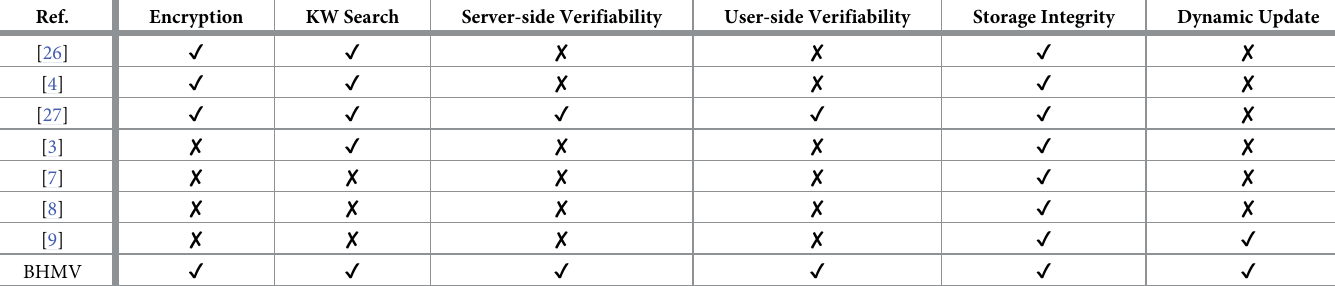
Table 4. Blockchain-based healthcare management system—Key features comparison ( ✔ : Supported; ✘ : Not supported).